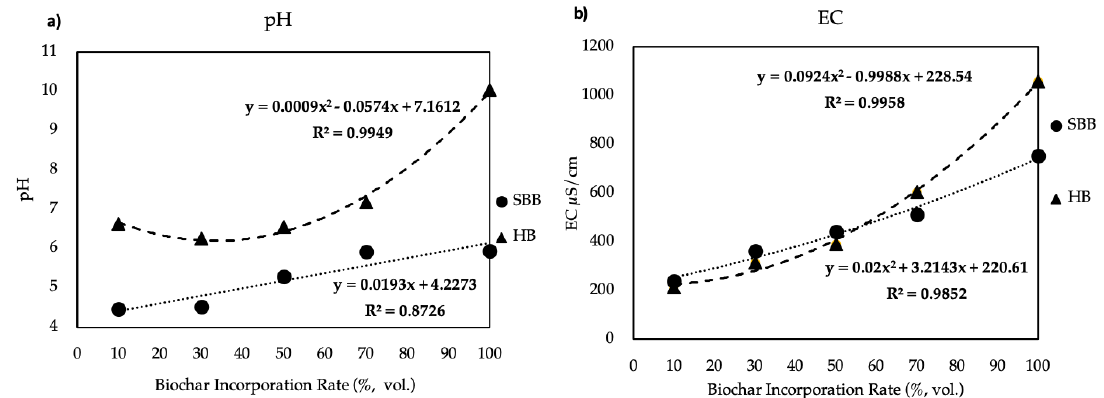
Figure 2. The correlation between pH (a) and electrical conductivity (EC) (b) and biochar incorporation rate. SBB = sugarcane bagasse biochar; HB = mixed hardwood biochar. SBB (10%, 30%, 50%, 70% and 100%; by vol.) incorporated with 30% perlite with the rest being peat moss; HB (10%, 30%, 50% and 70%; by vol.) incorporated with peat moss.